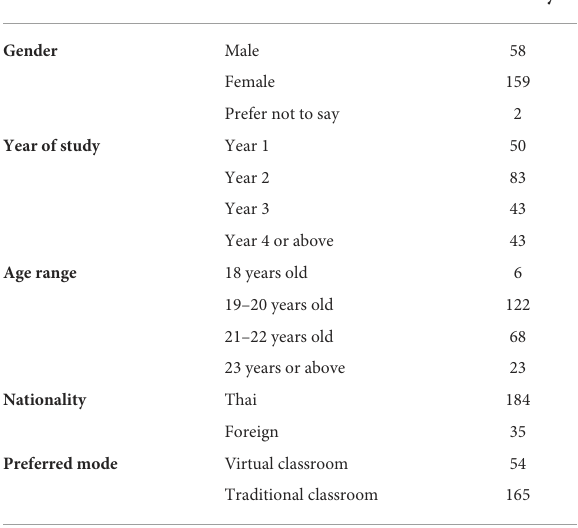
TABLE 1 Sample from Prince of Songkla University in Phuket, Thailand. Characteristics